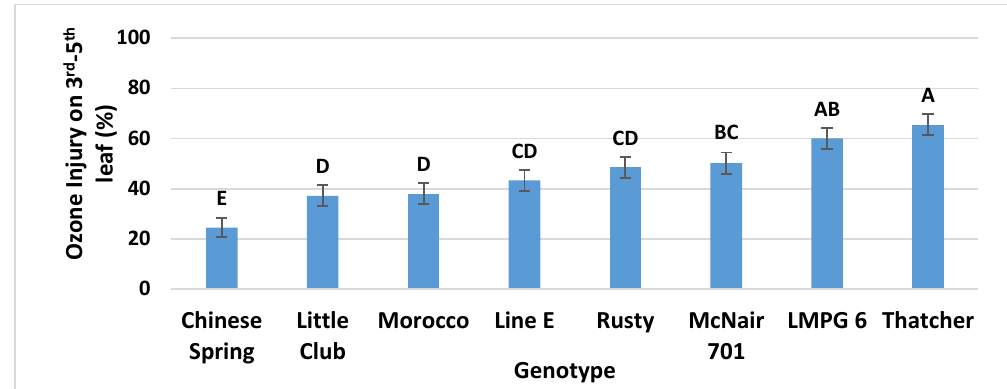
Figure 5. The overall average O 3 injury (on the third–fifth leaf) of rust near-universal susceptible genotypes, after exposure to three different O 3 levels (50, 70, 90 ppb) for 14 days (12 h/day), at 25 °C and 50% RH, in OPECs. Injury was visually estimated, under constant light conditions according to a 0 – 100% scale. Values are means (±SE) statistically separated using Tukey-Kramer adjustment for multiple comparisons. Means marked with the same letter are not significantly different at α = 0 .05.